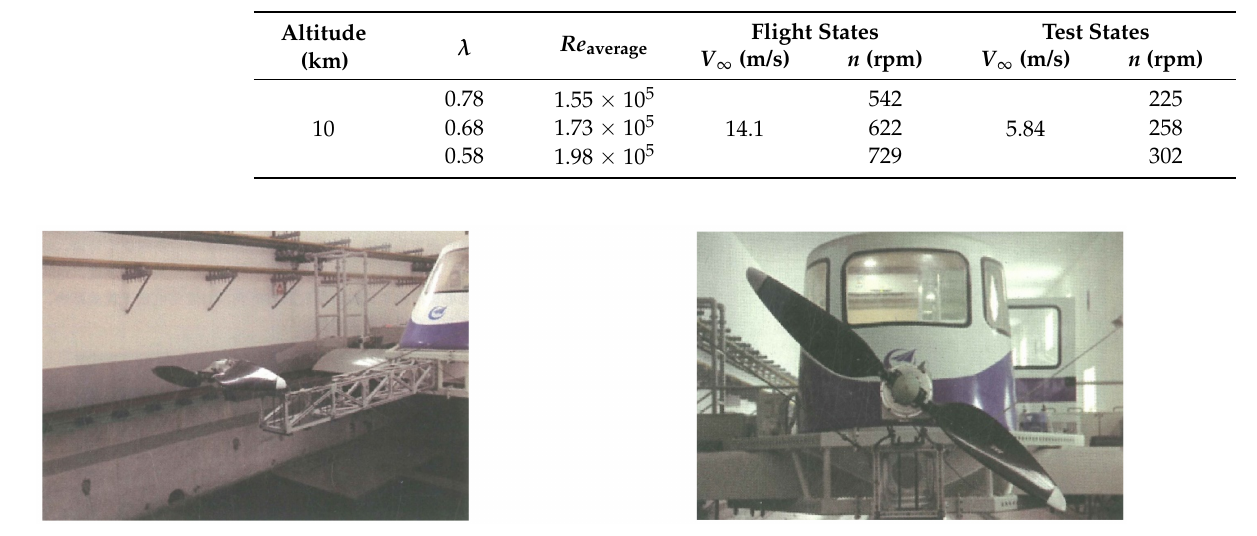
Figure 4. Three-dimensional shape of the test propeller. Table 2. Relation between the test states and flight states of the test propeller.